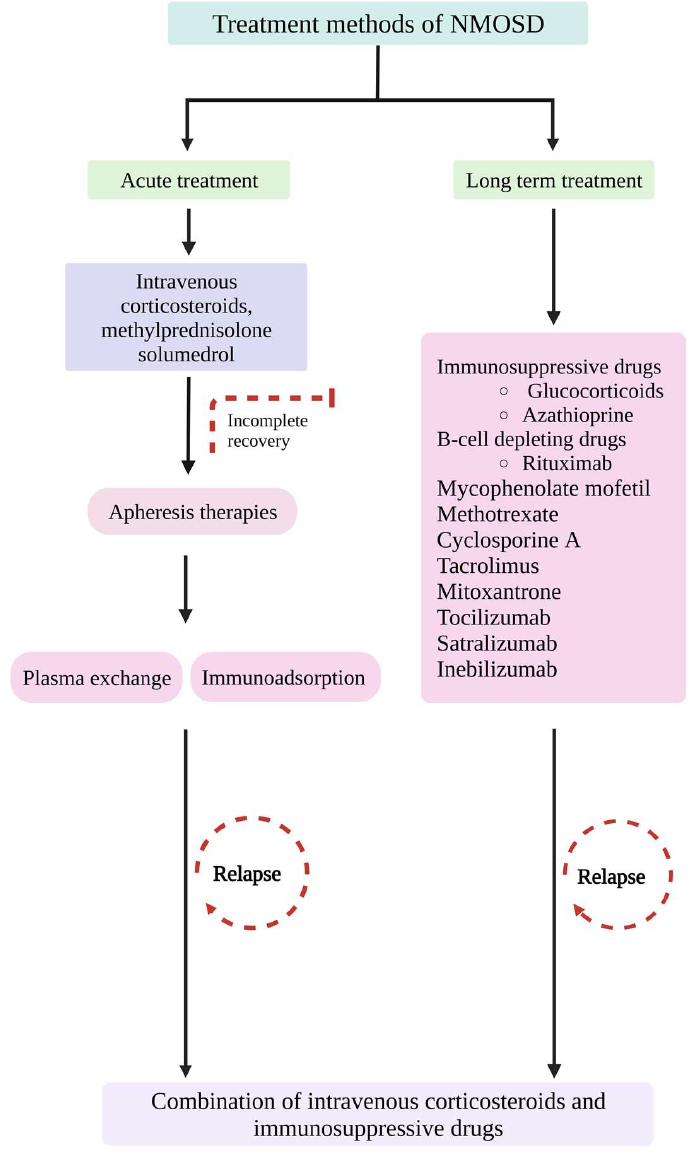
Figure 5. The illustration describes the pharmacological treatment methods for neuromyelitis opti- cal spectrum disorder (NMOSD). (Figure created using BioRender.com; accessed on 11 April 2023).